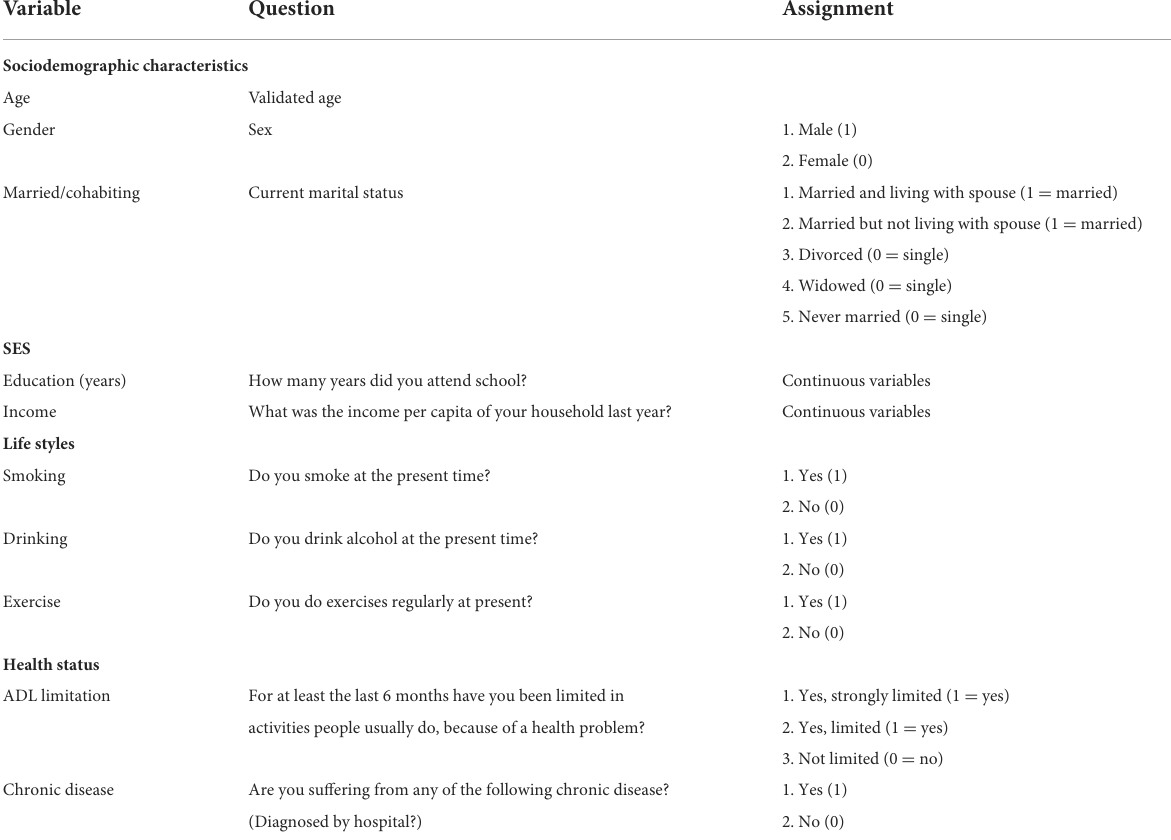
TABLE 1 Covariates and